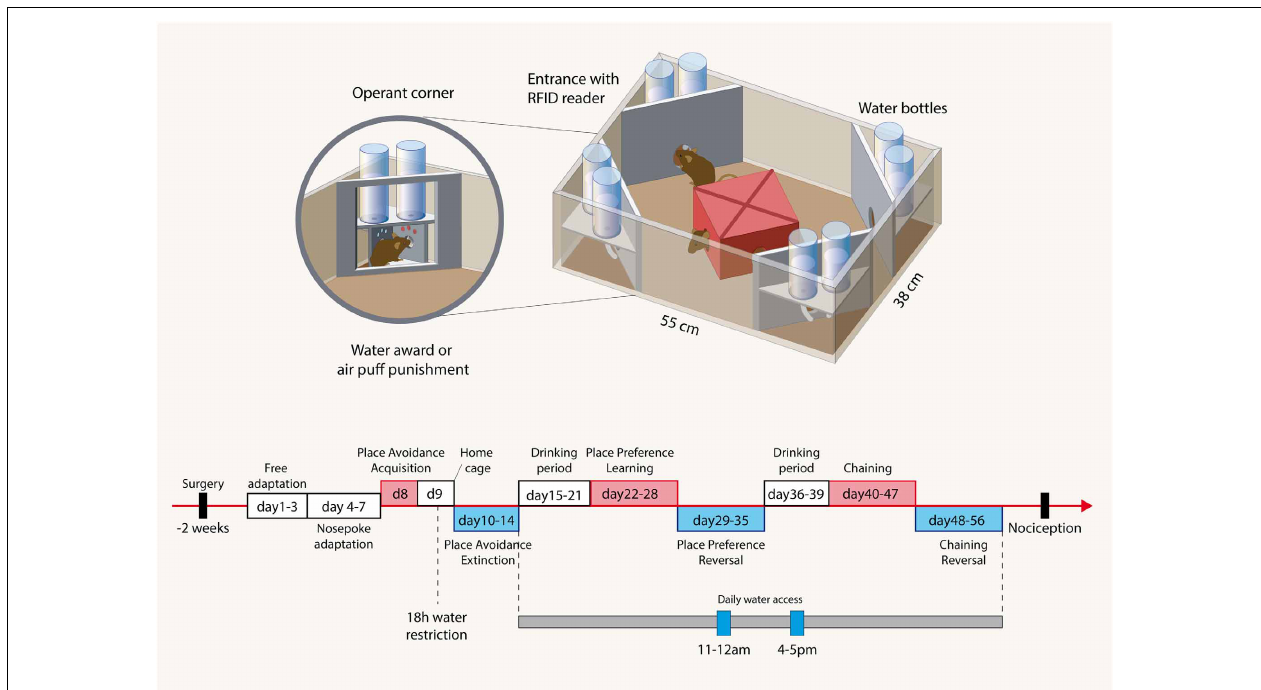
FIGURE 1 | Illustration of the IntelliCage and the time course of experimental tasks. Cage: The IntelliCage consists of four operant corners, each with two water bottles, sensors and doors that control the access to the water bottles. Mice are tagged with radio-frequency identification transponders (RFID), which are read at the corner entrance. Inside the corners, there are two holes with water bottles, which can be opened and closed by automated doors. Mice have to make a nosepoke to open the doors for water access. The IntelliCage is controlled by a computer. The number and duration of corner visits, nosepokes, licks, and contact times with the nipples of the water bottles are automatically recorded. Time schedule: The spared nerve injury and sham surgeries were performed 2 weeks before starting the free adaptation in the IntelliCage with free access to water in all corners. During “nosepoke adaptation” mice had to perform a nosepoke to get water, which was possible in every corner. In the “avoidance